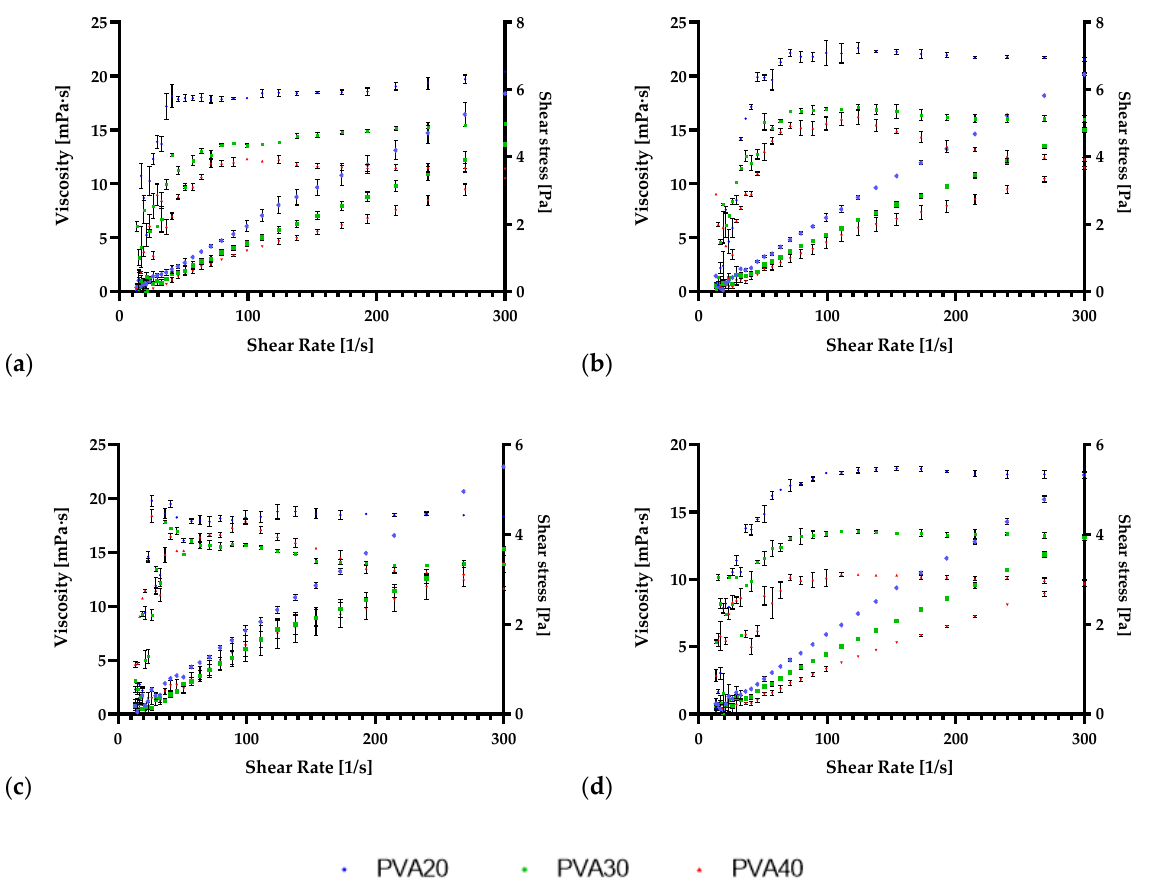
Figure 2. Shear viscosity and shear rate of PVA and itaconic acid-based biofilms at 20, 30, and 40 °C temperature. The reported mean values with standard deviation ( ± ) are displayed for ( a ) PVA + glycerol; ( b ) PVA + glycerol+ itaconic acid; ( c ) PVA + glycerol+ itaconic acid + phenolic extract; ( d ) PVA + glycerol + itaconic acid + organic extract.